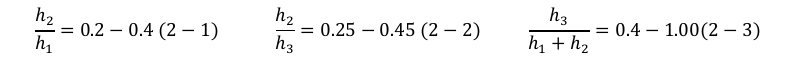
Table 5: Geometric repetitive proportions in the elevations of Sassanid square domes Table 5. Geometric repetitive proportions in the elevations of Sassanid square